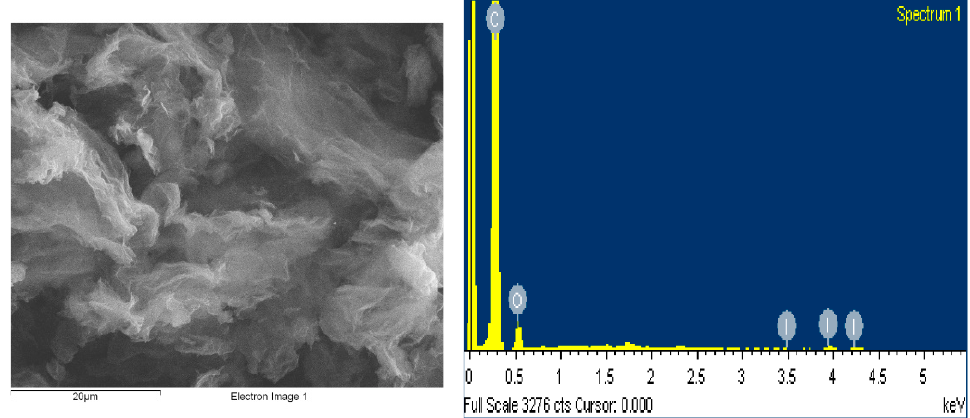
Figure 1. SEM microstructure and energy dispersive X-ray spectroscopy spectrum of prepared I-doped graphene oxide. Table 1. Elemental concentration of the iodine-doped graphene sample.